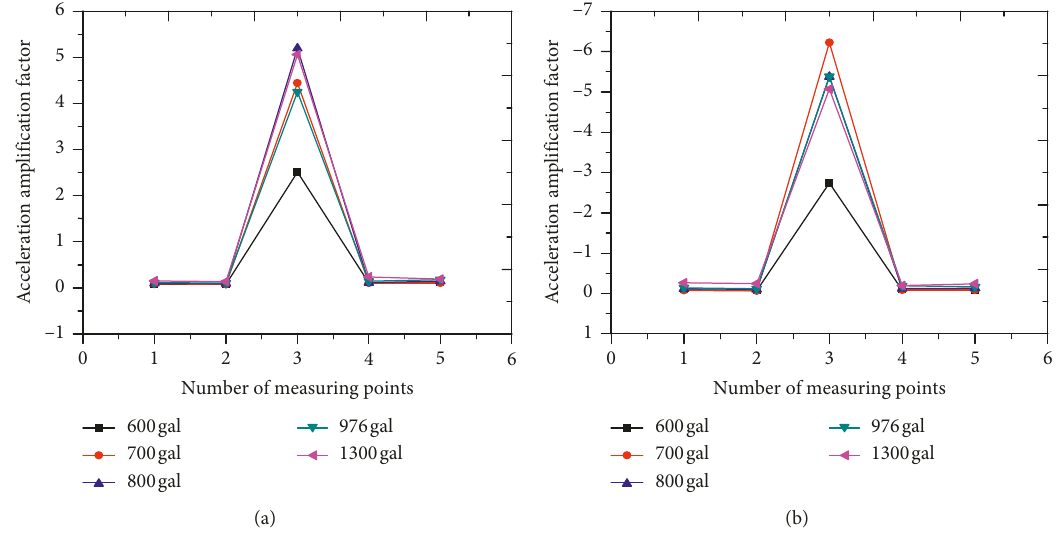
Figure 8: Acceleration magnification factor of loess slope.